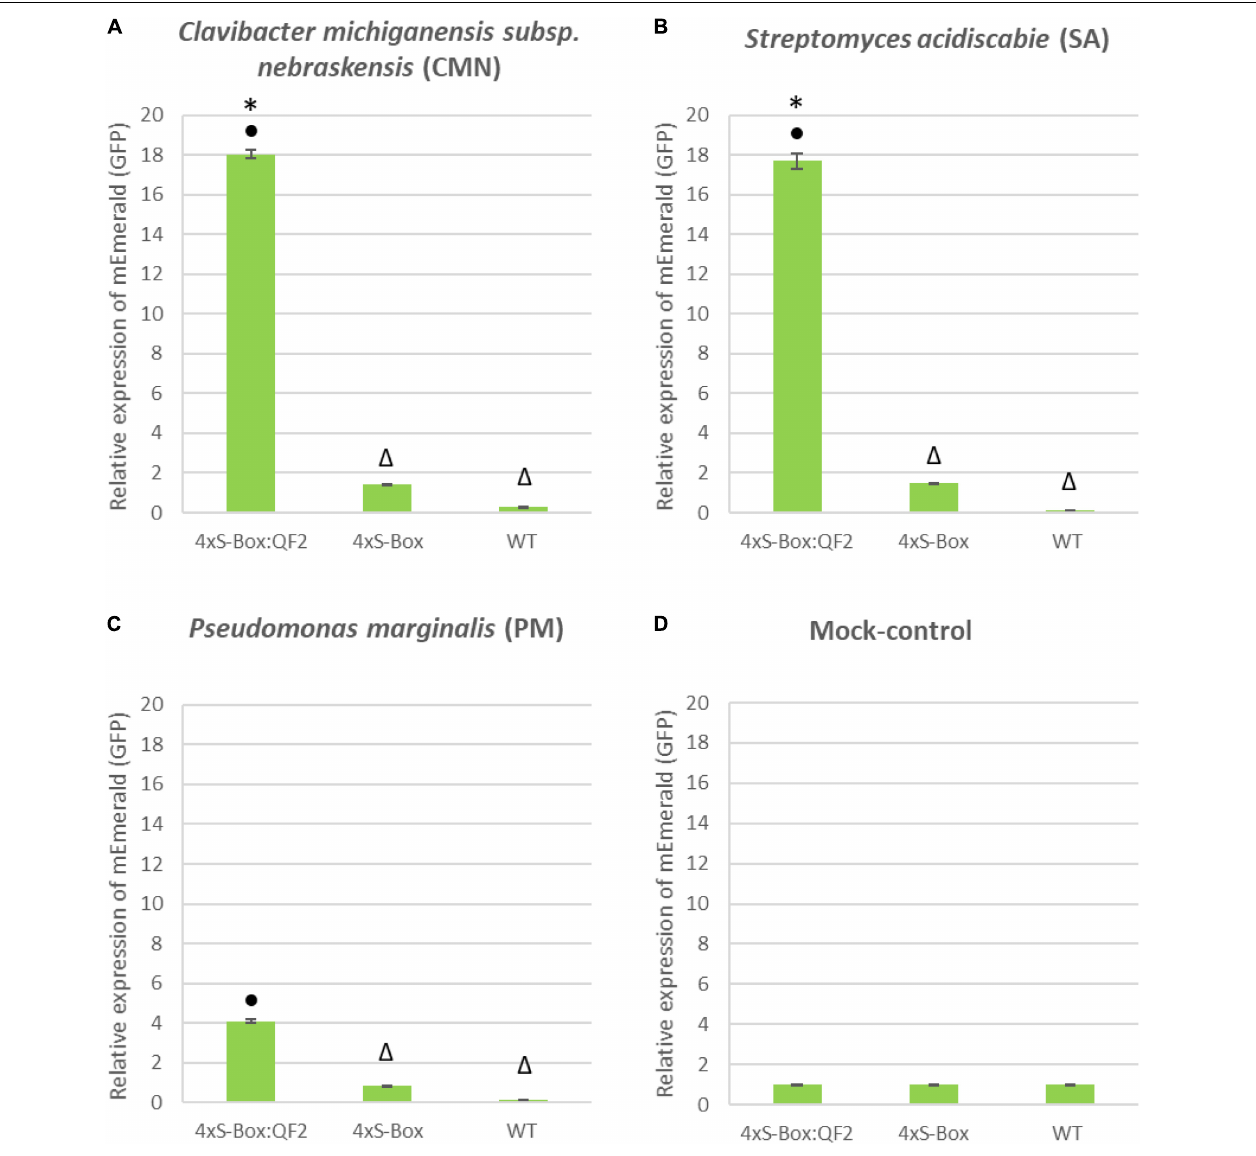
FIGURE 6 | qRT-PCR expression analysis of mEmerald in 4xS-Box and 4xS-Box:QF2 treated with bacterial pathogens. RNA extracted from leaves of 6-week-old stable transgenic 4xS-Box and 4xS-Box:QF2 potato plant 72 h post inoculation with bacterial pathogens: (A) Clavibacter michiganensis subsp. nebraskensis (CMN), (B) Streptomyces acidiscabie (SA), and (C) Pseudomonas marginalis (PM). (D) Mock control, plants treated with 10 mM MgCl 2 solution. Statistically significant differences determined using ANOVA, LSD post hoc analysis. Statistically significant ( p < 0.05) differences in mEmerald expression between lines indicated by: • from WT (wild type); * from 4xS-Box and (cid:52) from 4xS-Box:QF2. Transcript levels were normalized to potato elongation factor 1-alpha gene. RNA extracted from three biological replicates ( n = 3), with three technical replicated pooled from each leaf. Three technical replicate qRT-PCR reaction was performed per sample. Data represent mean ± standard error of three